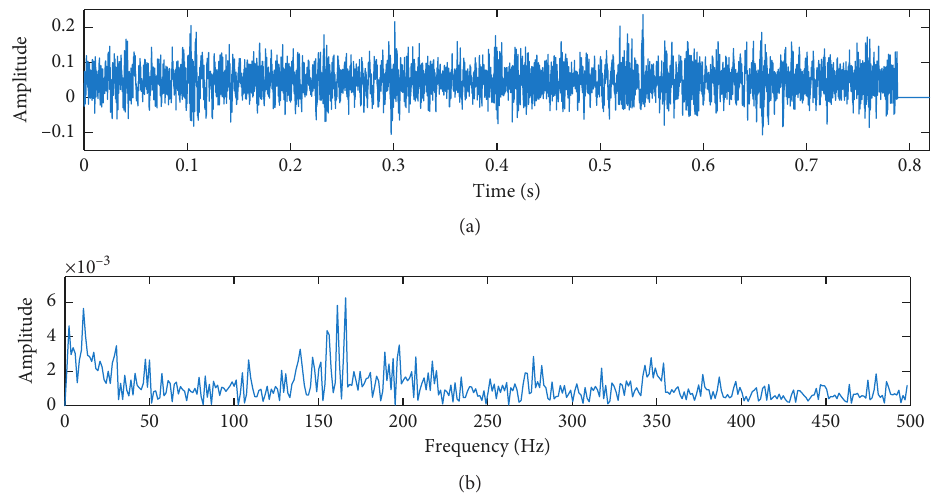
Figure 28: The wave of multicomponents data: (a) waveform; (b) envelope spectrum.